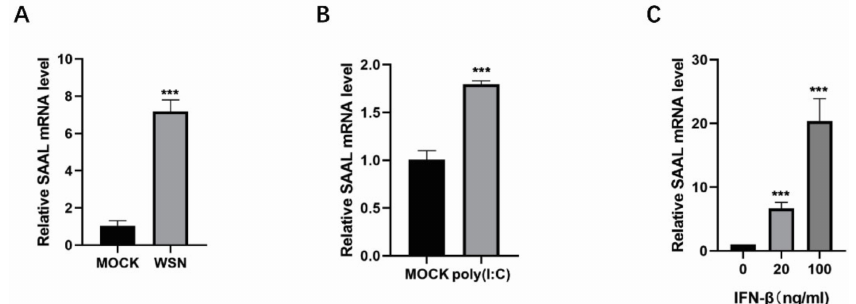
Figure 3. SAAL is an interferon-stimulated gene and can be induced by several viruses. ( A ) Mle-12 cells were infected with WSN, and RT-qPCR was performed to determine the mRNA level of SAAL. The means for three independent experiments ± SD are shown ( n = 3; means and SD; *** p < 0.001). ( B ) Mle-12 cells were stimulated by poly(I:C). The means for three independent experiments ± SD are shown ( n = 3; means and SD; *** p < 0.001). ( C ) Mle-12 cells were stimulated with increasing amounts of IFN- β for 16 h. RT-qPCR was performed to determine the levels of SAAL. The means for three independent experiments ± SD are shown ( n = 3; means and SD; *** p < 0.001).